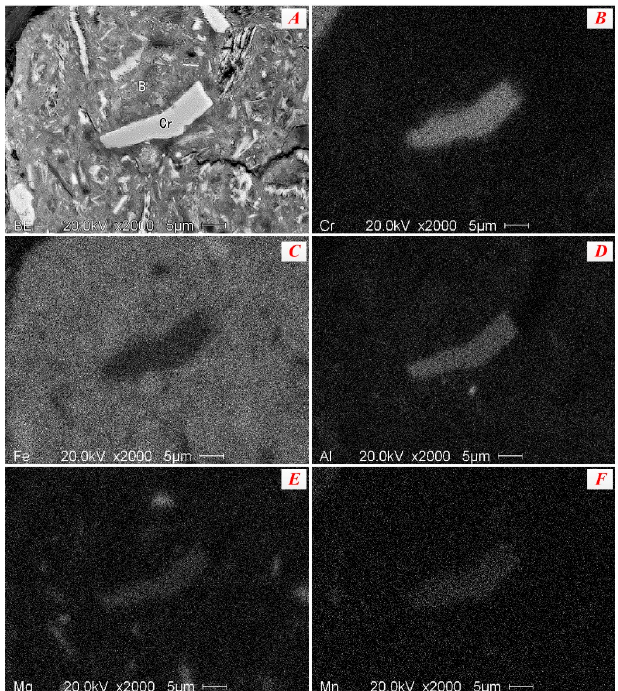
Figure 8. ESEM results of slag sample (( A ) backscattering electronic image; ( B – F ) surface scanning images of Cr, Fe, Al, Mg and Mn, respectively. (Cr-picotite, B-gangue)).